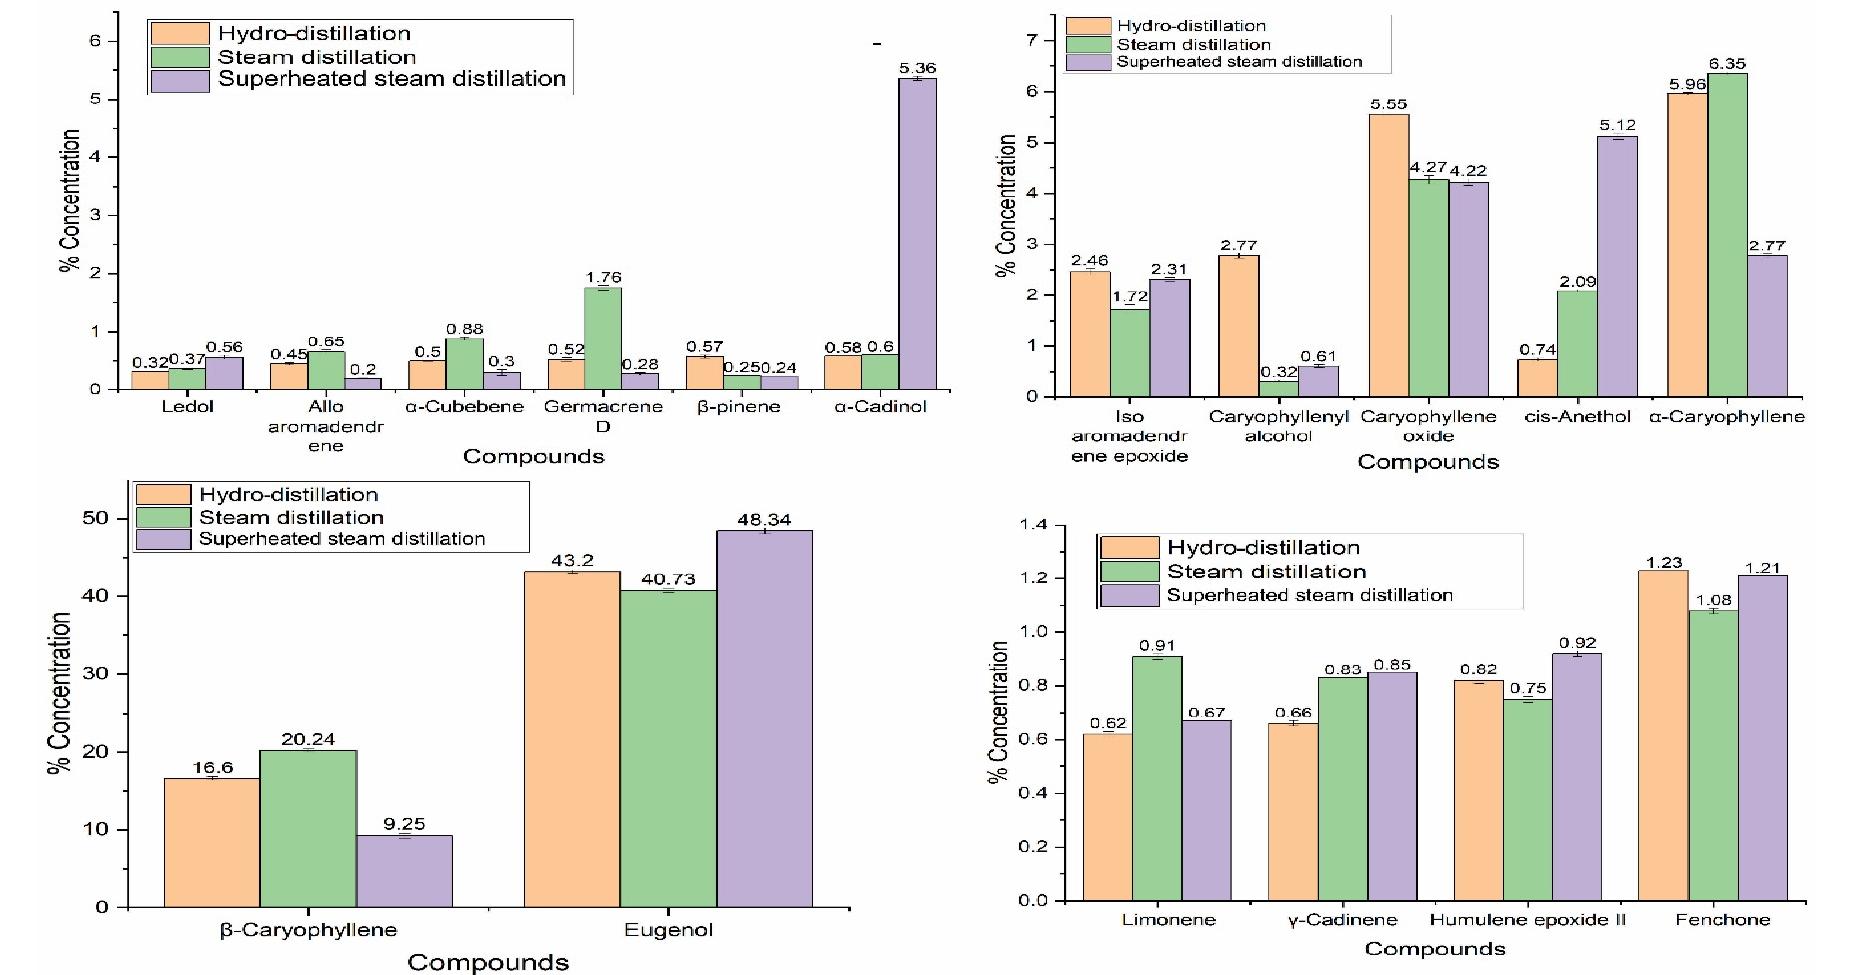
Figure 2. Variations in chemical components of S. aromaticum essential oils extracted by hydro-distillation, steam distillation, and superheated steam distillation.